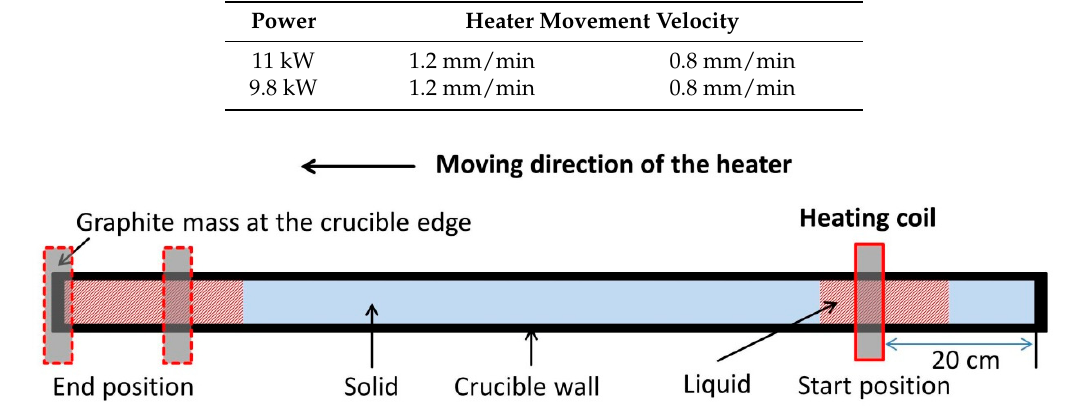
Figure 1. Sketch of the zone refining process.